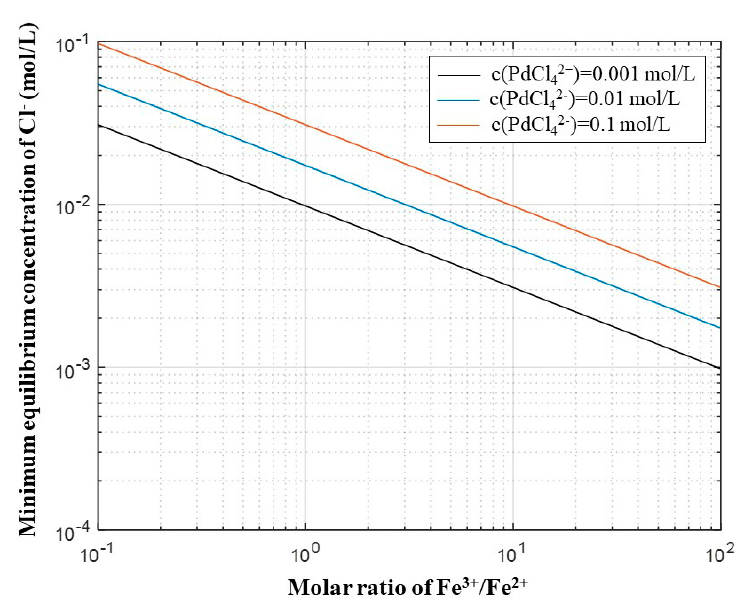
Figure 3. The relationship between the molar ratio of Fe 3+ /Fe 2+ and the necessary concentration of chloride for oxidation of Pd to PdCl 42 − .